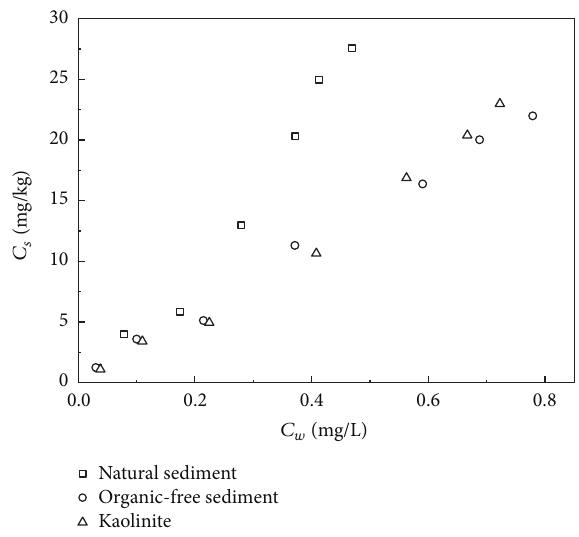
Figure 2: Sorption isotherms of phenanthrene on 3 sorbents.